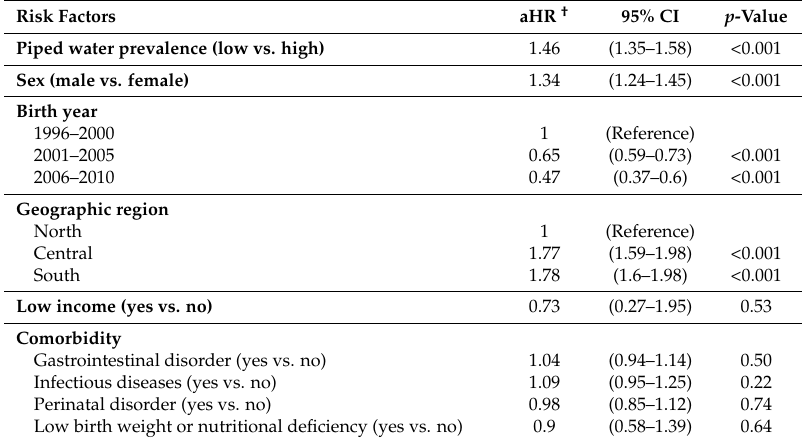
Table 4. Multivariate analysis of risk factors for pediatric appendicitis.